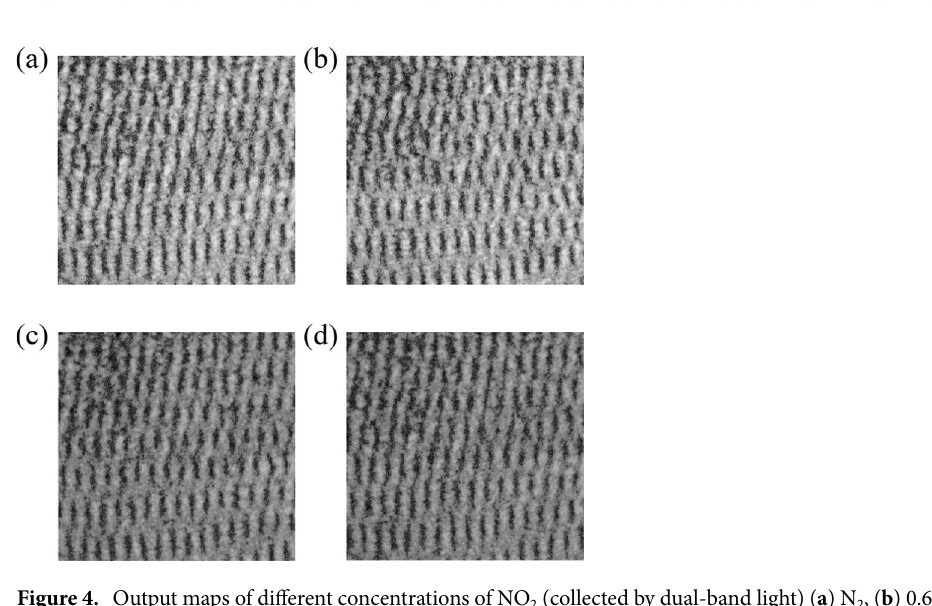
Figure 3. Output maps of different concentrations of NO 2 (collected by single-band light) ( a ) N 2 , ( b ) 0.6%, ( c ) 0.8%, ( d ) 1.0%.